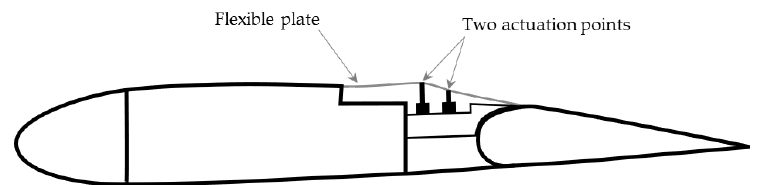
Figure 13. Shock control bump concept with a flexible plate and two actuation points based on [87], initially from [10].